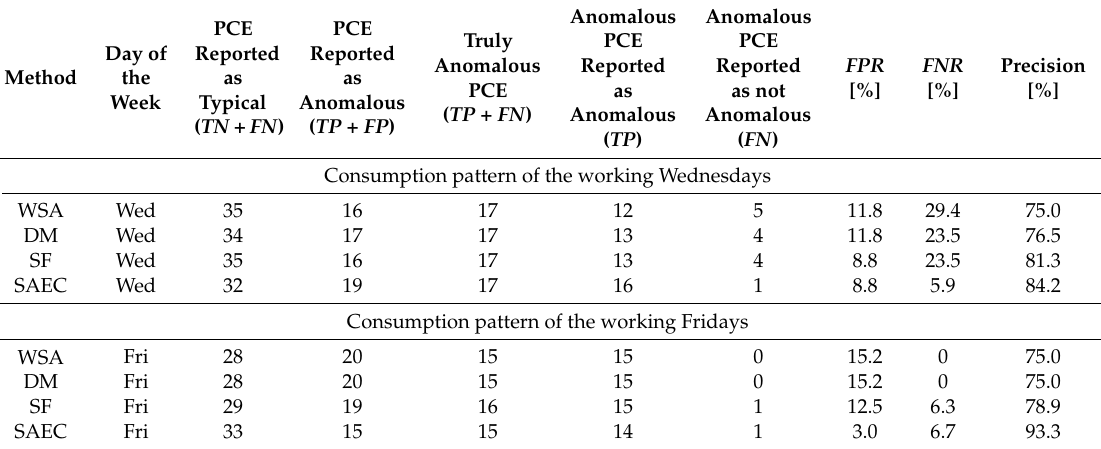
Table 4. Details of the obtained patterns: Universidad Politécnica